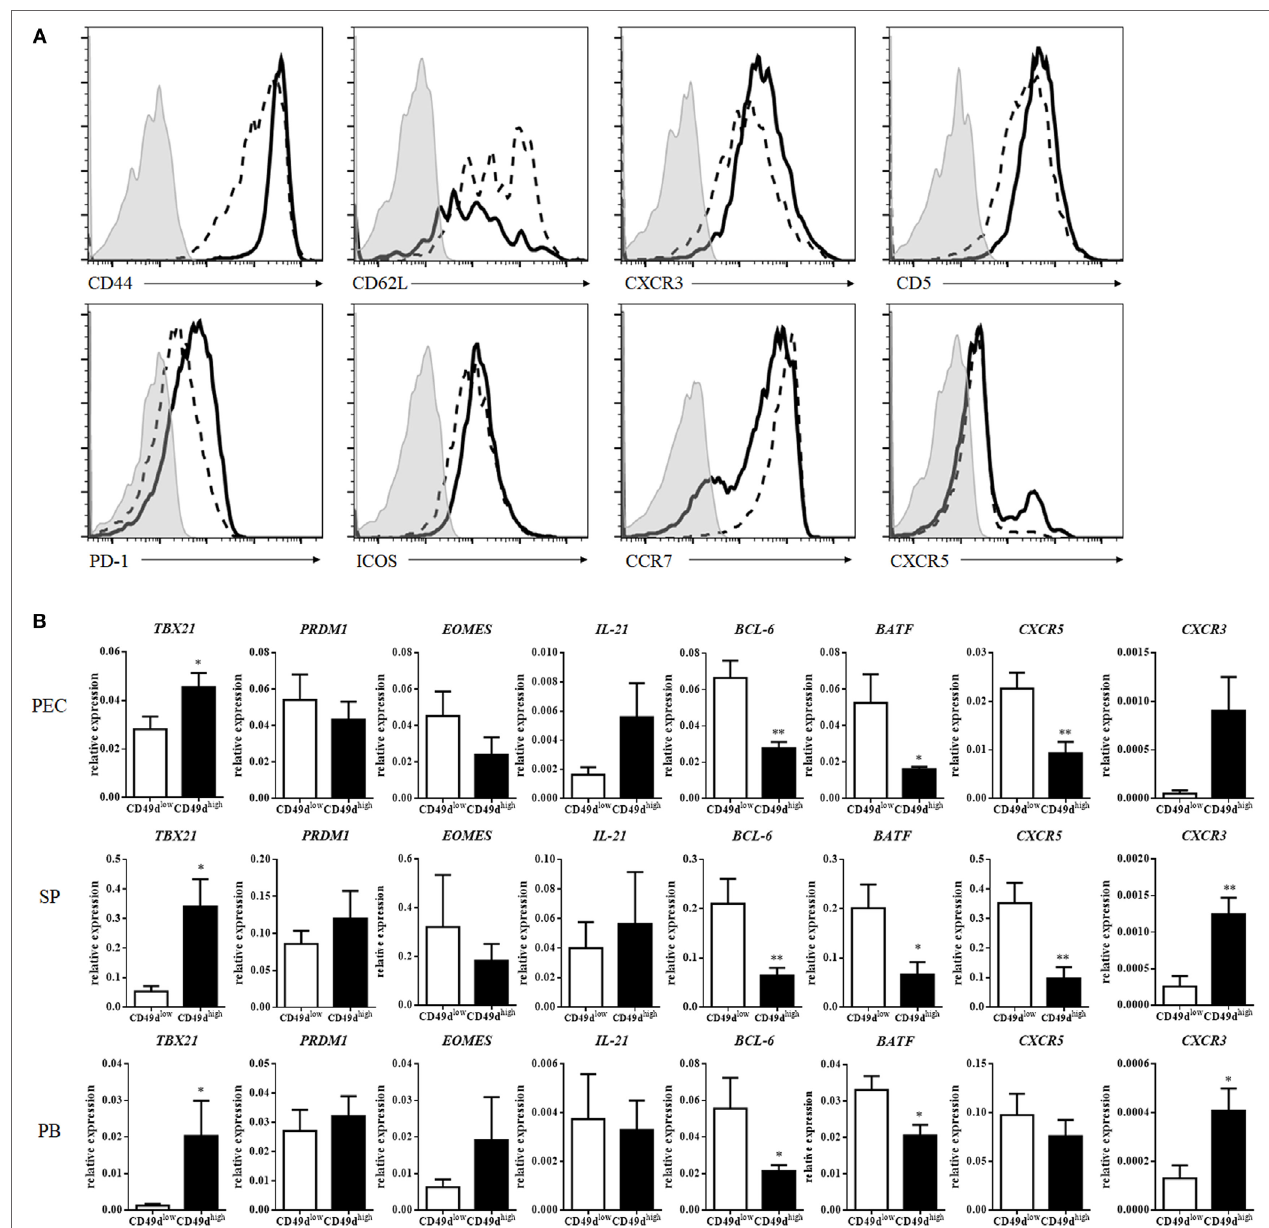
FigUre 2 | CD49d high CD4 + T cells exhibited a Th1-like memory phenotype. (a) Expression of surface proteins on human peritoneal CD49d high CD4 + T cells (solid line), CD49d low CD4 + T cells (dotted line), and isotype control group (gray filled). These data were representative of five independent donor experiments. (B) mRNA expression profiles of CD49d high CD4 + (black) and CD49d low CD4 + T cells (white) in the human PEC, SP, and PB. Real-time analysis was performed using sorted CD49d high CD4 + and CD49d low CD4 + T cells. The expression levels of various genes in CD49d high CD4 + T cells were compared with those in CD49d low CD4 + T cells. The data were expressed as the mean ± SEM ( n = 4–10 donors per each group). * P < 0.05, ** P < 0.01; Student’s t -test. Abbreviations: PEC, peritoneal cavity; SP, spleen; PB, peripheral